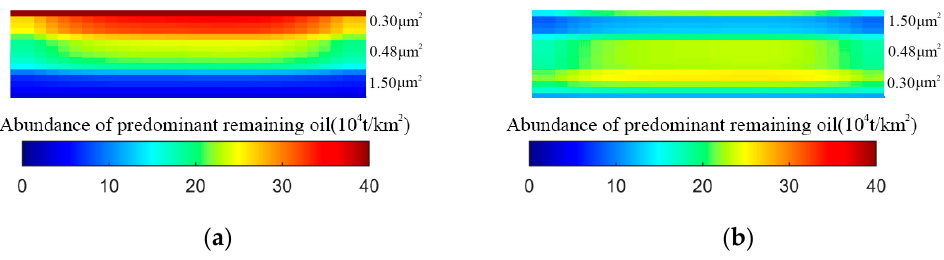
Figure 4. Fluid velocity profile near injector with different rhythm models. ( a ) Positive rhythm; ( b ) reverse rhythm.